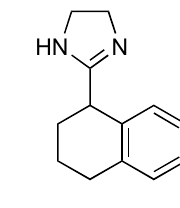
Table 20. Epidermal flux and tissue retention of VCs and SA following application to human skin.